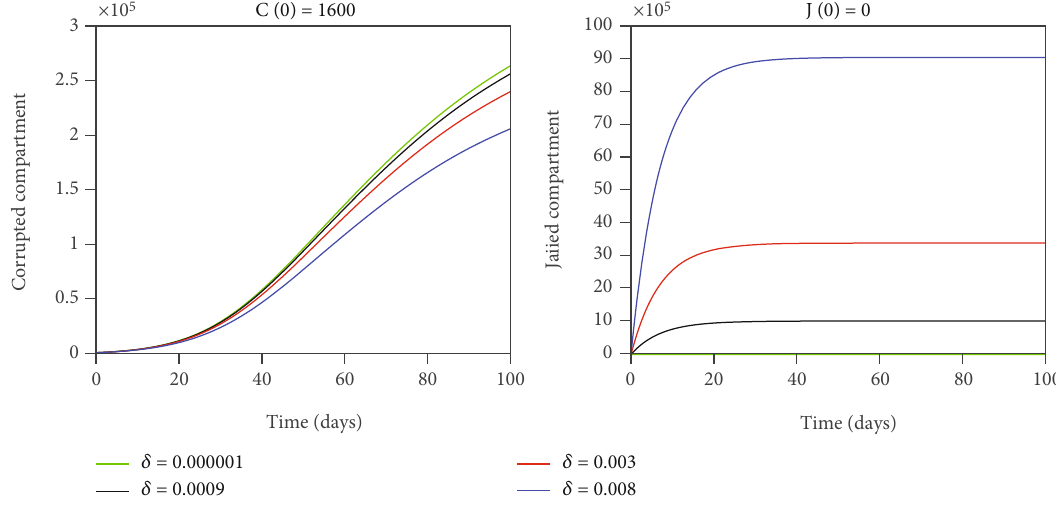
Figure 4: Corrupted and jailed population with varying rate at which corrupted individuals are caught and imprisoned, δ .